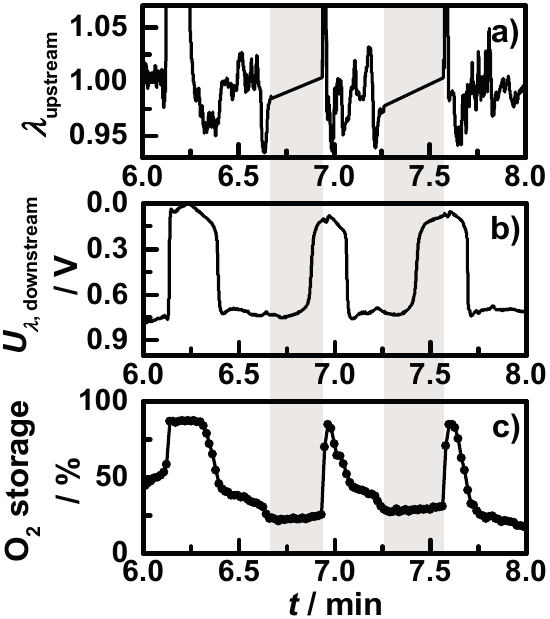
Figure 8. Section of the NEDC measurement with warm start conditions from Figure 7 showing the first two start-stop phases (shaded grey): ( a ) the air-fuel ratio λ measured by the upstream broadband lambda probe; ( b ) downstream lambda probe signal; and ( c ) the microwave-derived oxygen storage